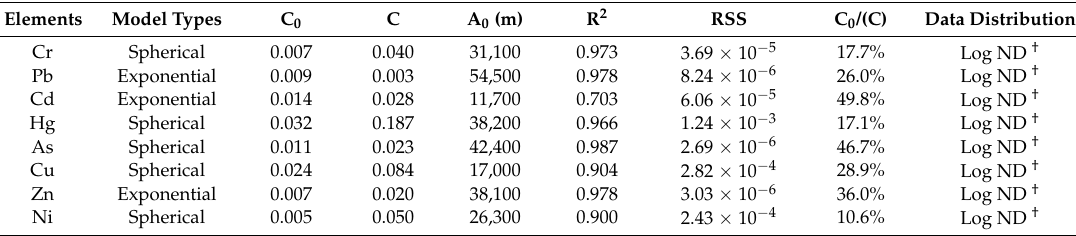
Table 3. Parameters of the semivariogram models of different heavy